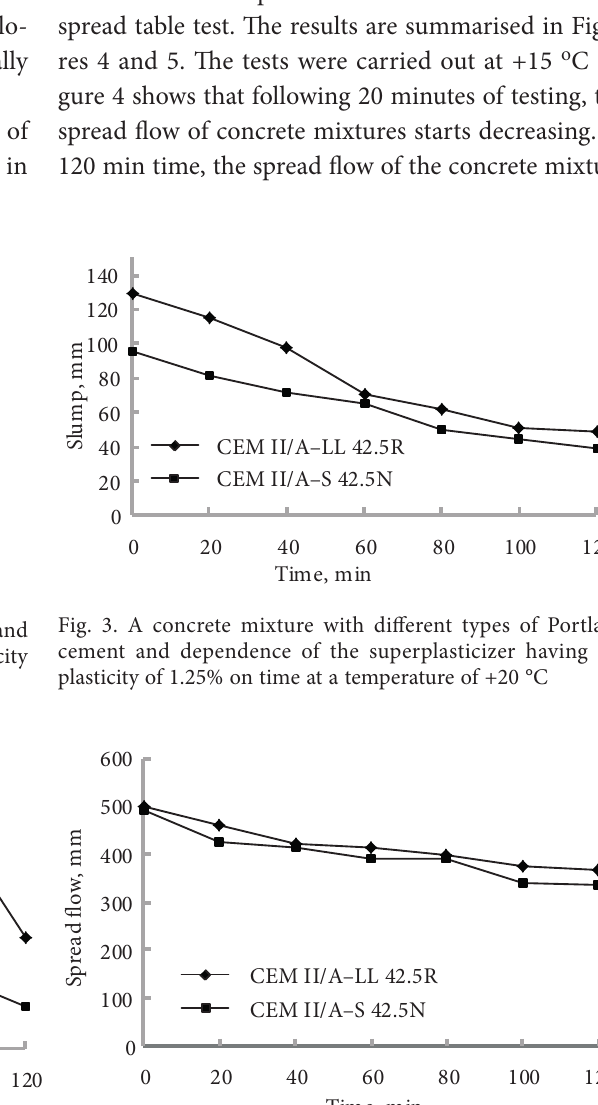
Fig. 2. A concrete mixture with different types of Portland cement and dependence of the superplasticizer having the plasticity of 1.25% on time at a temperature of +15 °C